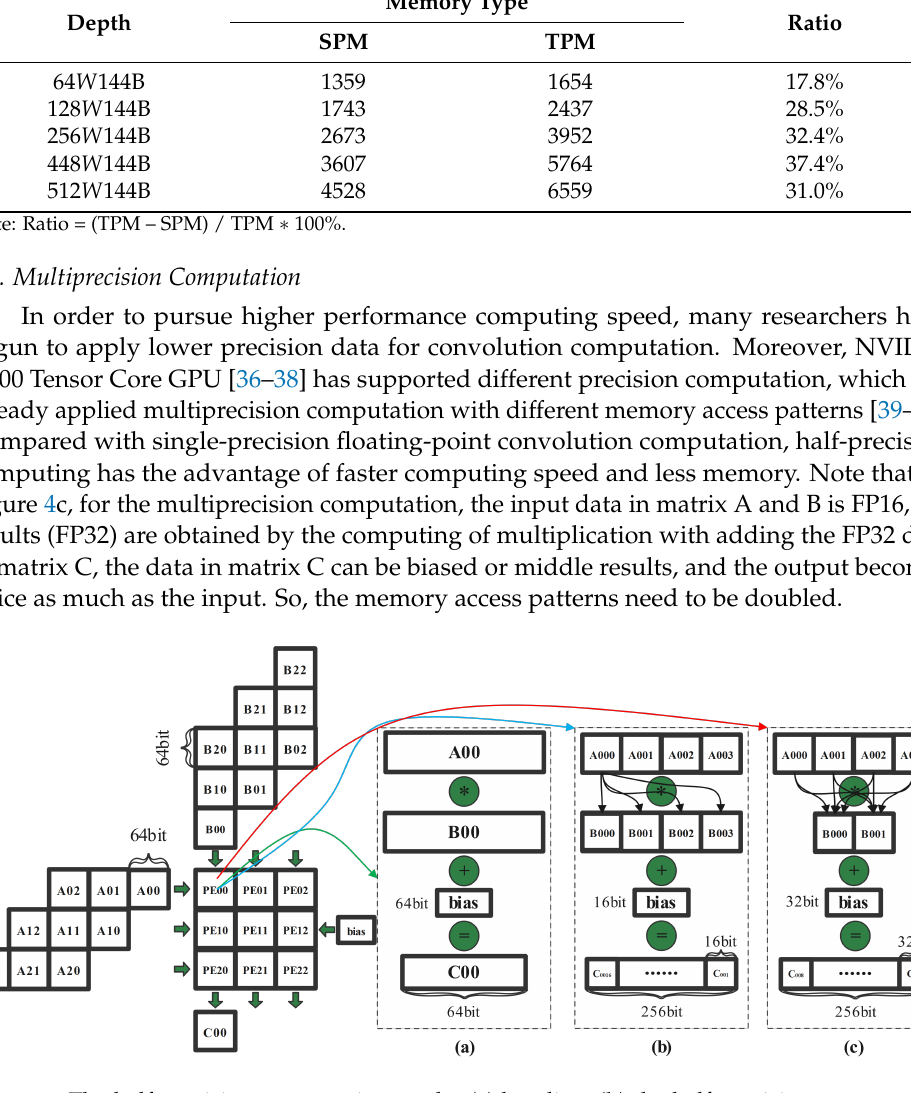
Figure 4. The half-precision computation mode: ( a ) baseline; ( b ) the half-precision computation; ( c ) the multiprecision